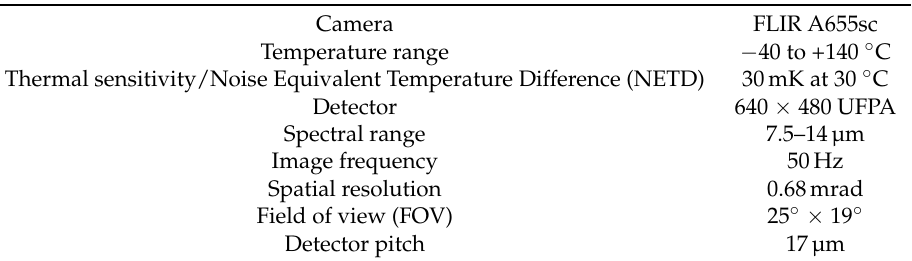
Table 1. Technical specifications of the infrared camera FLIR A655sc used in the experiments.